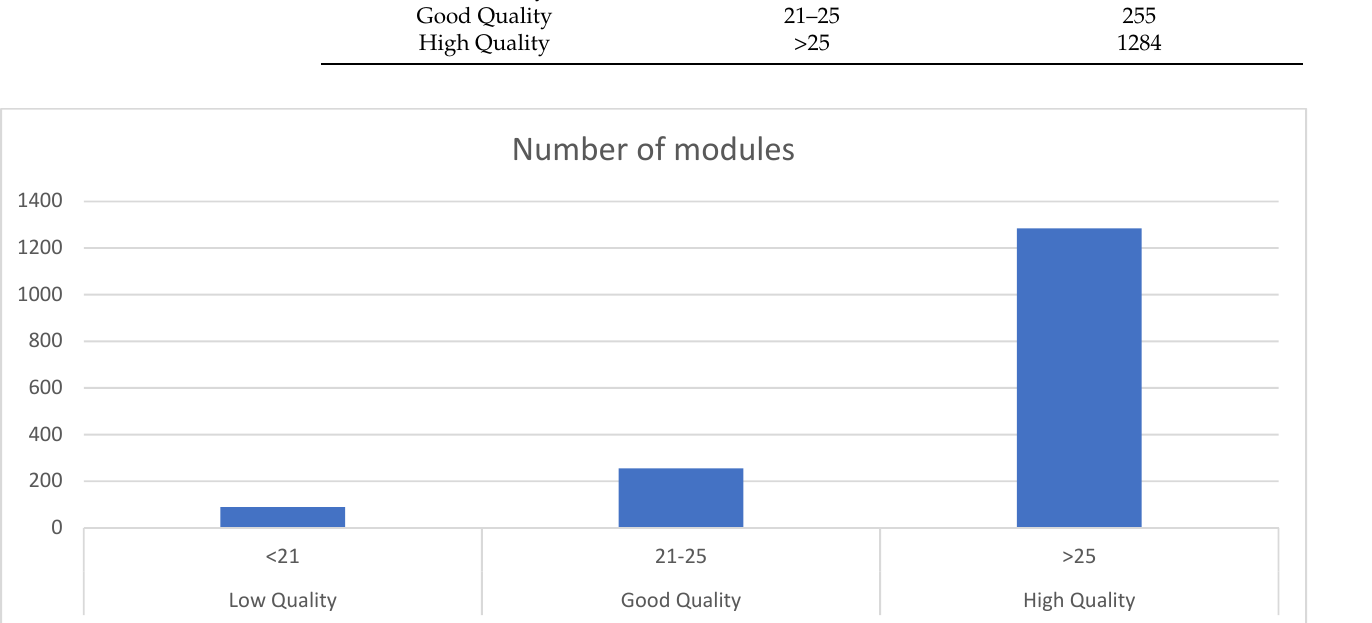
Figure 7. New classification of the s-serie laser modules based on their output power.